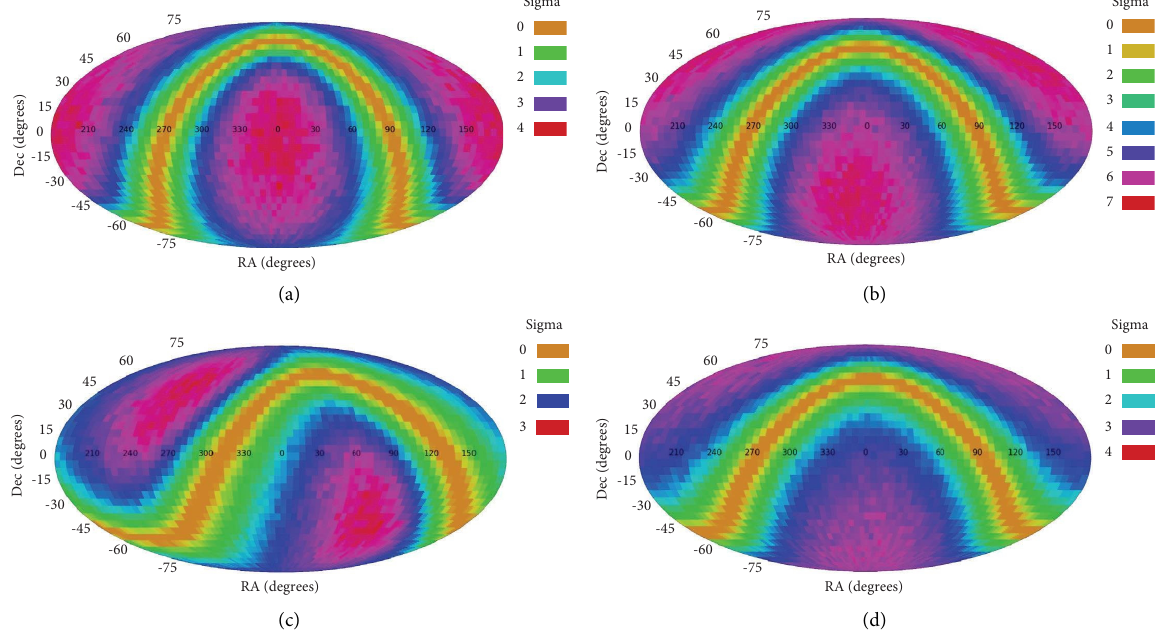
Figure 2: Te χ 2 statistical signifcance of a dipole axis from diferent ( α , δ ) when using SpArcFiRe for the annotation of the galaxy spin directions and diferent methods of selecting spiral galaxies: (a) computer selection, (b) no spiral selection, (c) Galaxy Zoo selection with 95% threshold (“superclean”), and (d) Galaxy Zoo selection with 80% threshold (“clean”). Table 3: Most likely locations of the dipole axes observed in the diferent